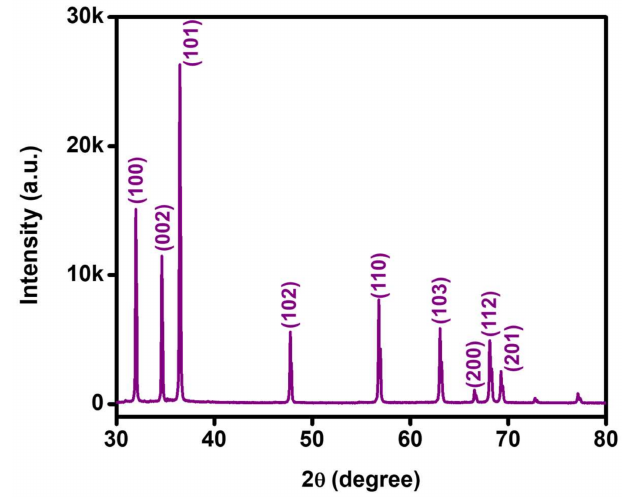
Figure 2. XRD analysis of the synthesized ZnO